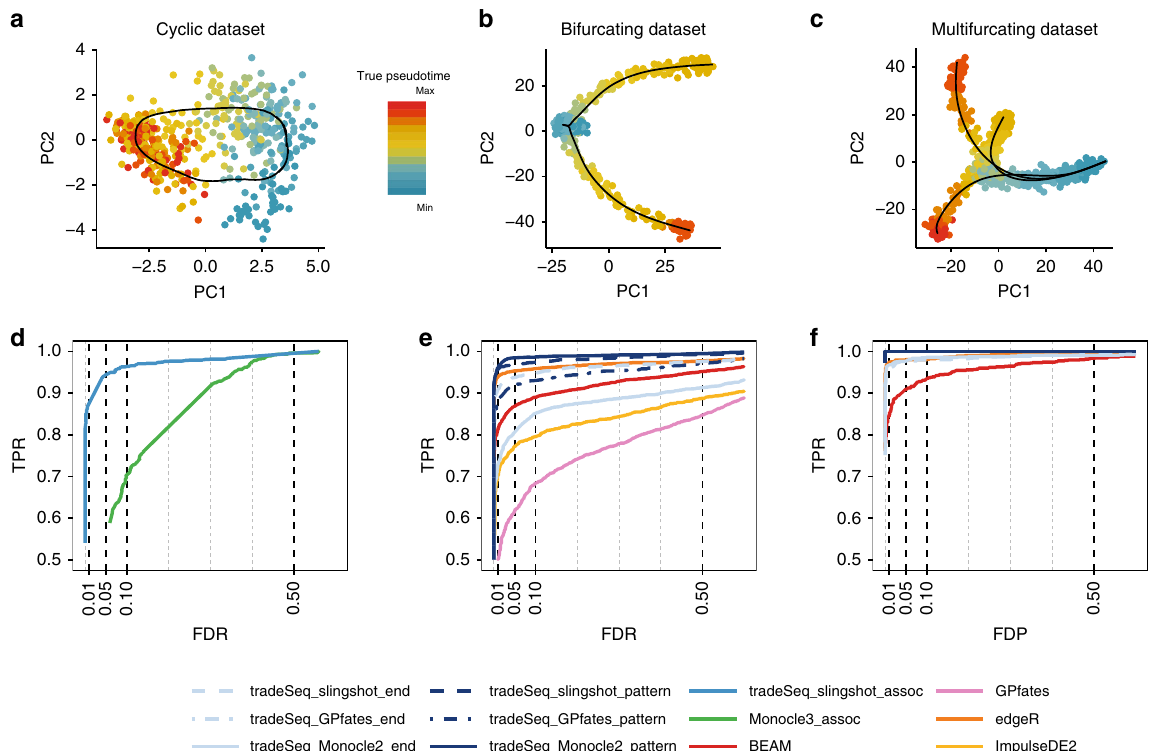
Fig. 3 Simulation study results. PCA plots for the ( a ) cyclic, ( b ) bifurcating, and ( c ) multifurcating simulated trajectories. The plotting symbol for each cell is colored according to its true pseudotime; trajectories (in black) were inferred by princurve in ( a ) and slingshot in ( b ) and ( c ). d – f Scatterplot of the true positive rate (TPR) vs. the false discovery rate (FDR) or false discovery proportion (FDP) for various DE methods applied to the simulated data sets. Panel ( d ) displays the average performance curves of DE methods across seven out of ten cyclic data sets for which all DE methods worked (Monocle 3 errored on three data sets). The associationTest from tradeSeq has superior performance for discovering genes whose expression is associated with pseudotime, as compared with Monocle 3. When investigating differential expression between lineages of a trajectory, the patternTest of tradeSeq consistently outperforms the diffEndTest across all three TI methods, since it is capable of comparing expression across entire lineages. Panel ( e ) displays the average performance curves across the three bifurcating data sets where all TI methods recovered the correct topology. Here, all tradeSeq patternTest work fl ows, tradeSeq_slingshot_end, and edgeR have similar performance and all are superior to BEAM, ImpulseDE2, and GPfates. Note that the performance of tradeSeq_Monocle2_end deteriorates as compared with tradeSeq_slingshot_end; the curve for tradeSeq_GPfates_end is not visible in this panel due to its low performance. For the multifurcating data set of panel ( f ), tradeSeq_slingshot has the highest performance, closely followed by tradeSeq_Monocle2 and the diffEndTest is a smoother-based analog of discrete DE. For TI methods Monocle 2 and GPfates, diffEndTest performs poorly, which is not surprising since the endpoints are typically ill-de fi ned or arti fi cially extended in the inferred trajectories for these methods (Supplementary Figs. 9 and 10). In general, BEAM, ImpulseDE2, and GPfates are outperformed by the other methods. Across all methods, tradeSeq_slingshot has the best performance. Finally, we recapitulate that the perfor- mance curves in Fig. 3e do not provide a complete view of method performance, since seven out of ten data sets were not used because at least one method failed to recover the simulated trajectory. Supplementary Fig. 11 shows mean performance curves across all ten data sets for all methods, which clearly demonstrates the superiority of tradeSeq as a DE method and of slingshot as an upstream TI method. The performance and trajectories for all ten individual data sets are shown in Supplementary Fig. 12.